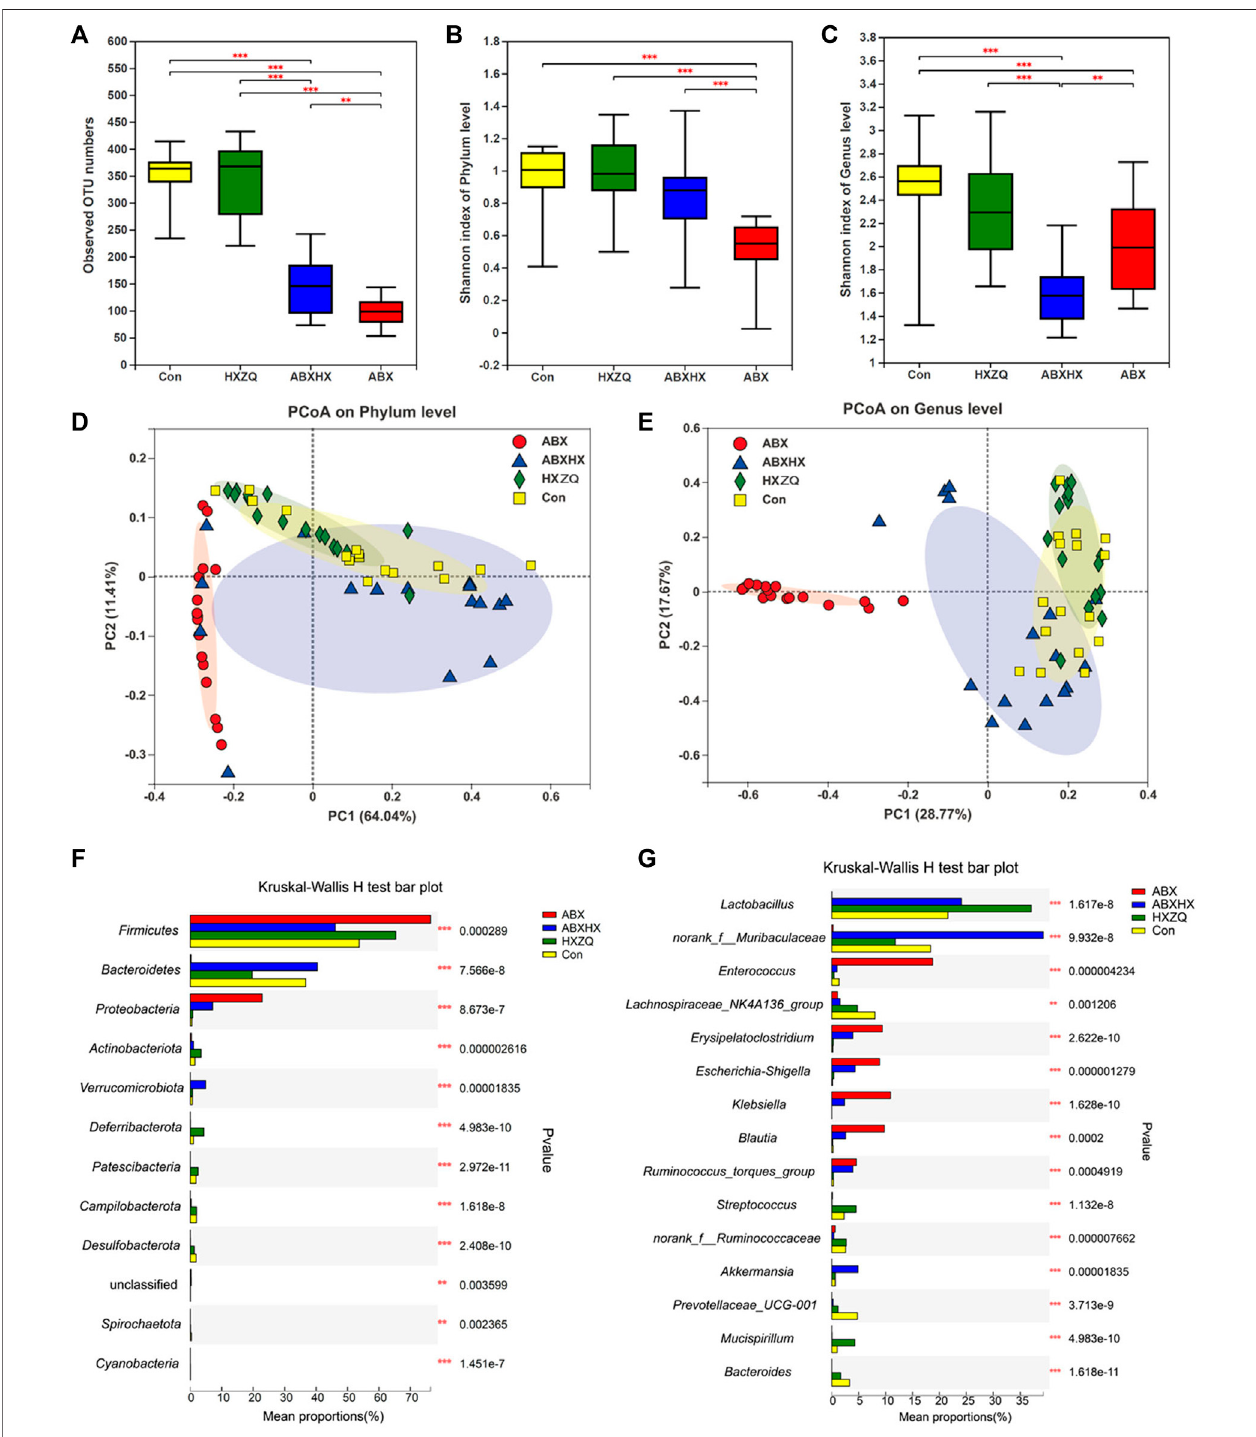
FIGURE 3 | Bacterial diversity analyses and comparison of bacterial community structure after HXZQ administration in antibiotic-induced gut microbiota dysbiosis micemodel( n =16ineachgroup).Alpha-diversitybasedonobservedOTUnumbers (A) andShannondiversityonphylumlevel (B) andgenuslevel (C) werecomparedin fourgroupmice.Bray – Curtisprincipalcoordinateanalysisonphylumlevel (D) andgenuslevel (E) ofgutmicrobiota. (F,G) Visualrepresentationof p -valuesobtainedfrom comparison of bacterial abundance on phylum and genus level between four groups. Kruskal – Wallis H test was applied. * p -value < 0.05; ** p < 0.01; *** p < 0.001.